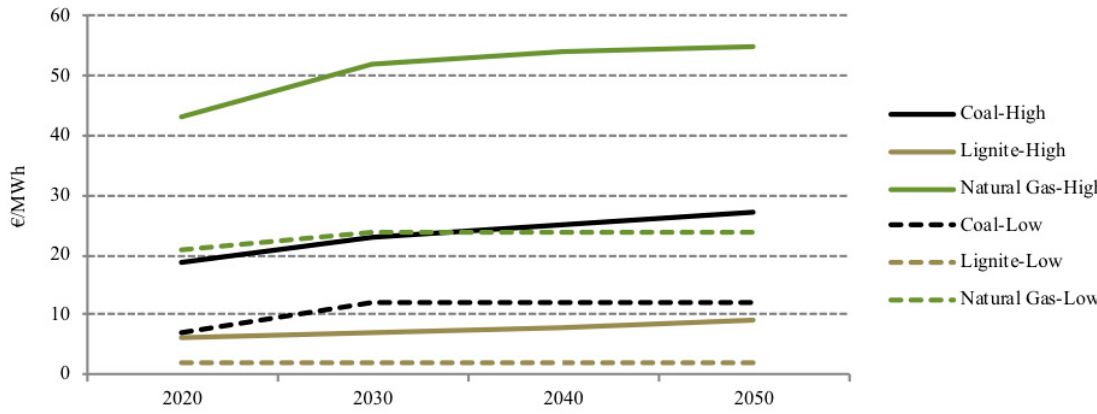
Figure 4. Assumed development paths for fossil fuel prices.